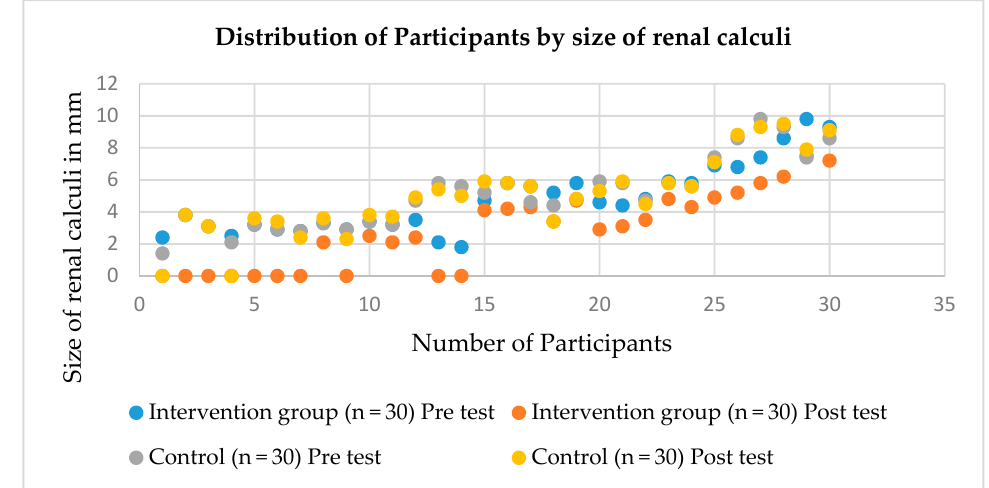
Figure 2. Distribution of renal Calculi.